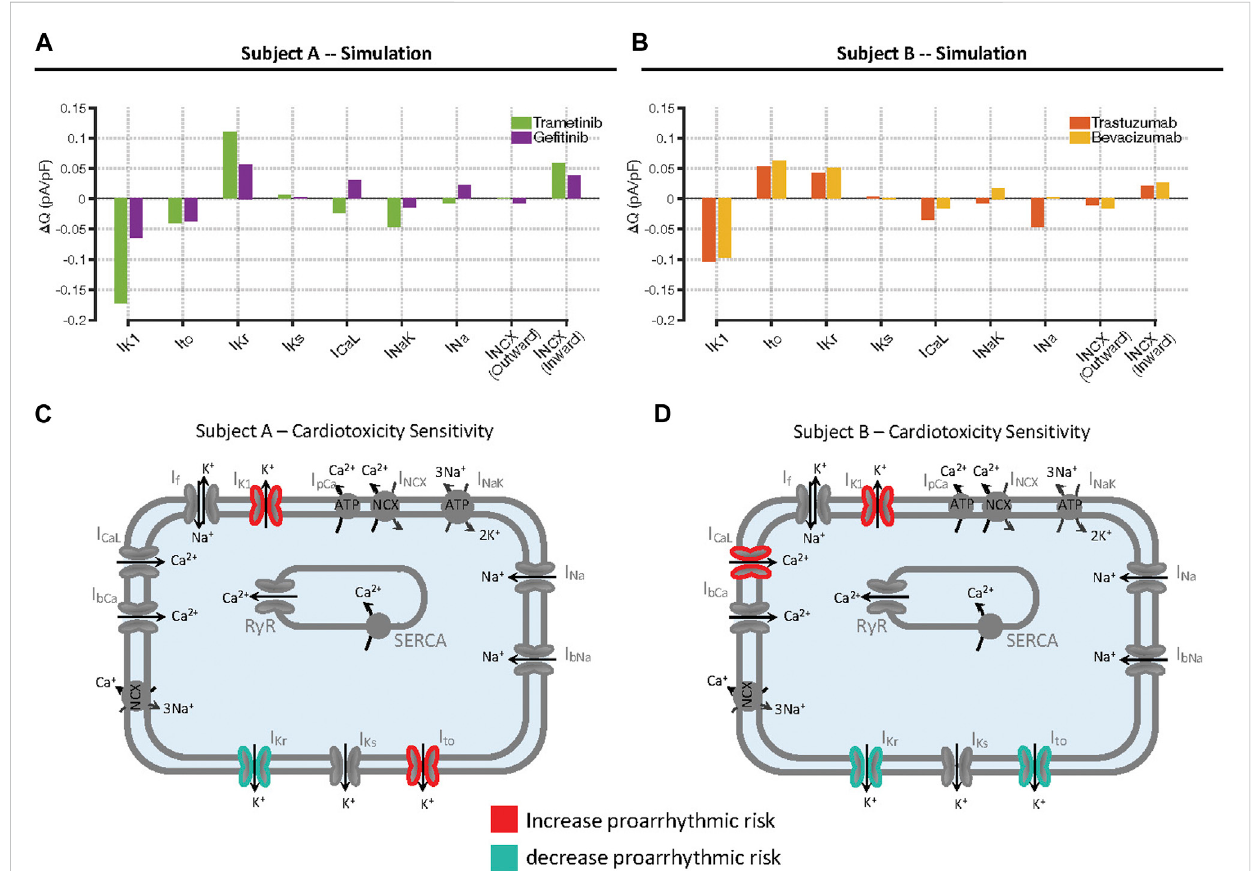
FIGURE 6 Mechanisms underlying increased arrhythmia susceptibility caused by individual drugs in the two cell lines. (A, B) Calculations of changes in total charge, Δ Q, passing through individual ionic currents, in Cell Lines A and B, respectively. Simulations were performed at the level of extracellular [K + ] immediatelybeforearrhythmiasoccurredindrug-treatedcells,andtheintegralofeachcurrentduringtheactionpotentialwascomputed.Barsrepresent the difference in integrated current, or charge (Q), between drug-treated and untreated cells. (C, D) Summary of changes in ionic currents that accounted for increased susceptibility in the two cell lines. Each panel shows the changes in ionic currents that act to increase arrhythmia risk in red, contrasted with the changes that act to decrease arrhythmia risk in